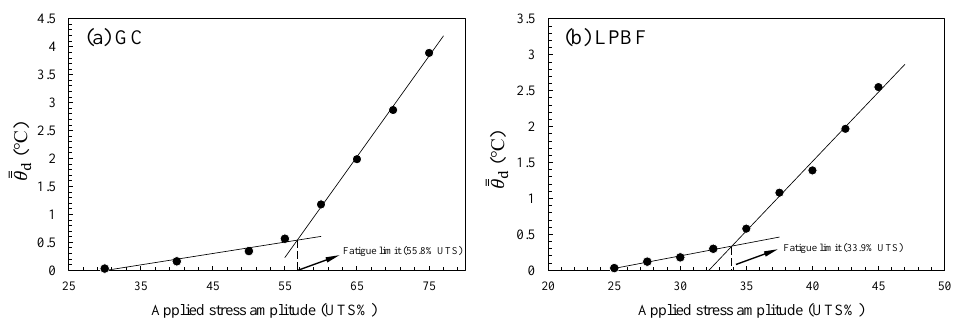
Figure 9. Fatigue limit prediction based on the relationship of the average temperature shift caused by energy dissipation: ( a ) GC specimen; ( b ) LPBF specimen.